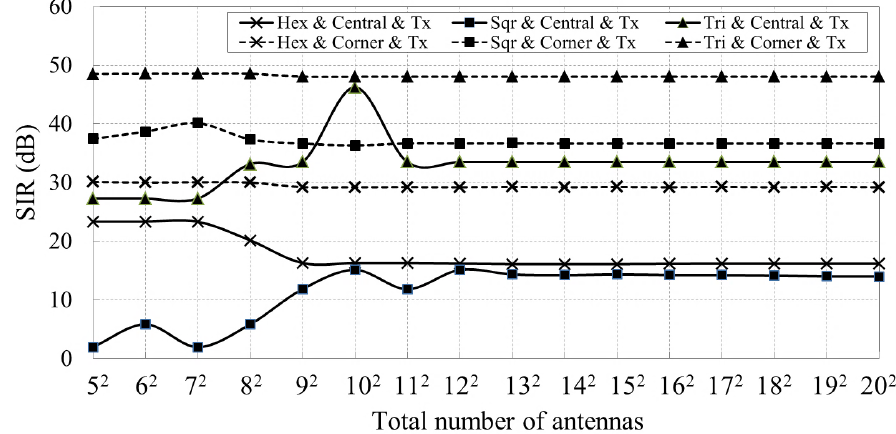
Figure 12. Received calibration signal’s SIR versus total number of antennas, where the solid lines show the calibration signal’s SIR when the central antenna is configured as a calibration signal transmitter. The dotted lines show the calibration signal’s SIR when the antenna at the top left corner of the array is the calibration signal transmitter.